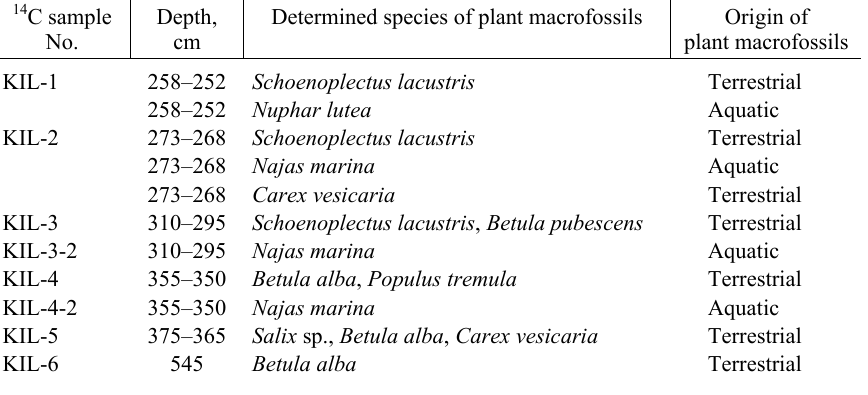
Table 3. Identified and dated plant